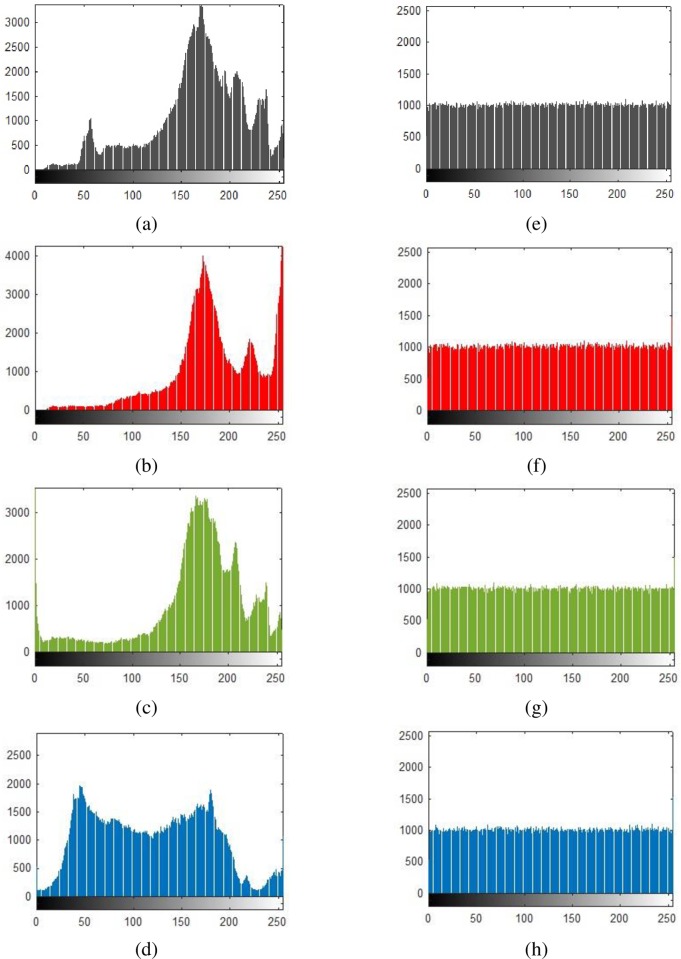
Histograms of Fruits image of size 512×512.(a) plain image histogram. (b) Red component histogram. (c) Green component histogram. (d) Blue component histogram. (e) Encrypted image histogram (f) Encrypted Red component histogram. (g) Encrypted Green component histogram (h) Encrypted Blue component histogram.